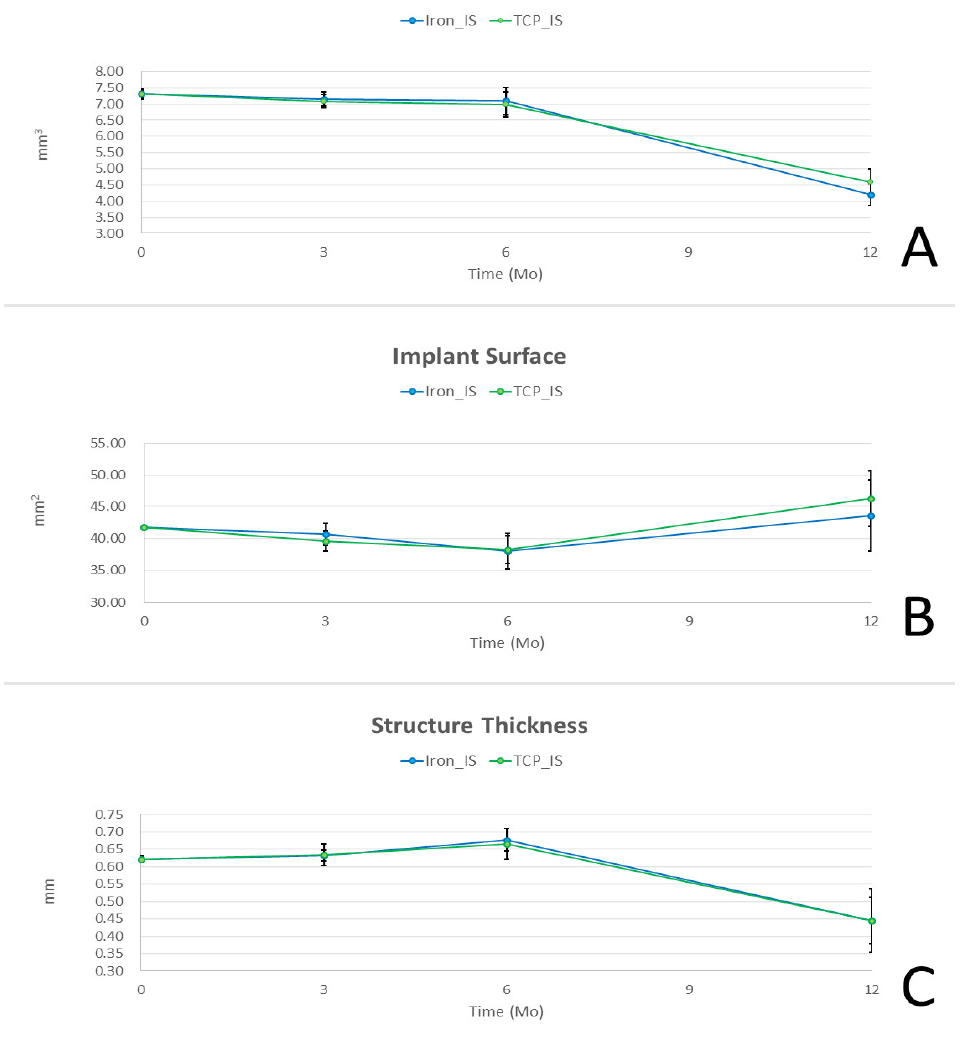
Figure 5. Degradation analysis of experimental interference screws using micro-CT based on their volume (IV; mm 3 ), surface area (mm 2 ), and structure thickness (Str_Thk, mm). The decrease in ( A ) IV and ( B ) implant surface area was slow during post-implantation months 0–6, but it accelerated later until post-implantation month 12. ( C ) Str_Thk slightly increased over post-implantation months 0–6 but decreased quickly over post-implantation months 6–12. Error bars represent standard deviations.